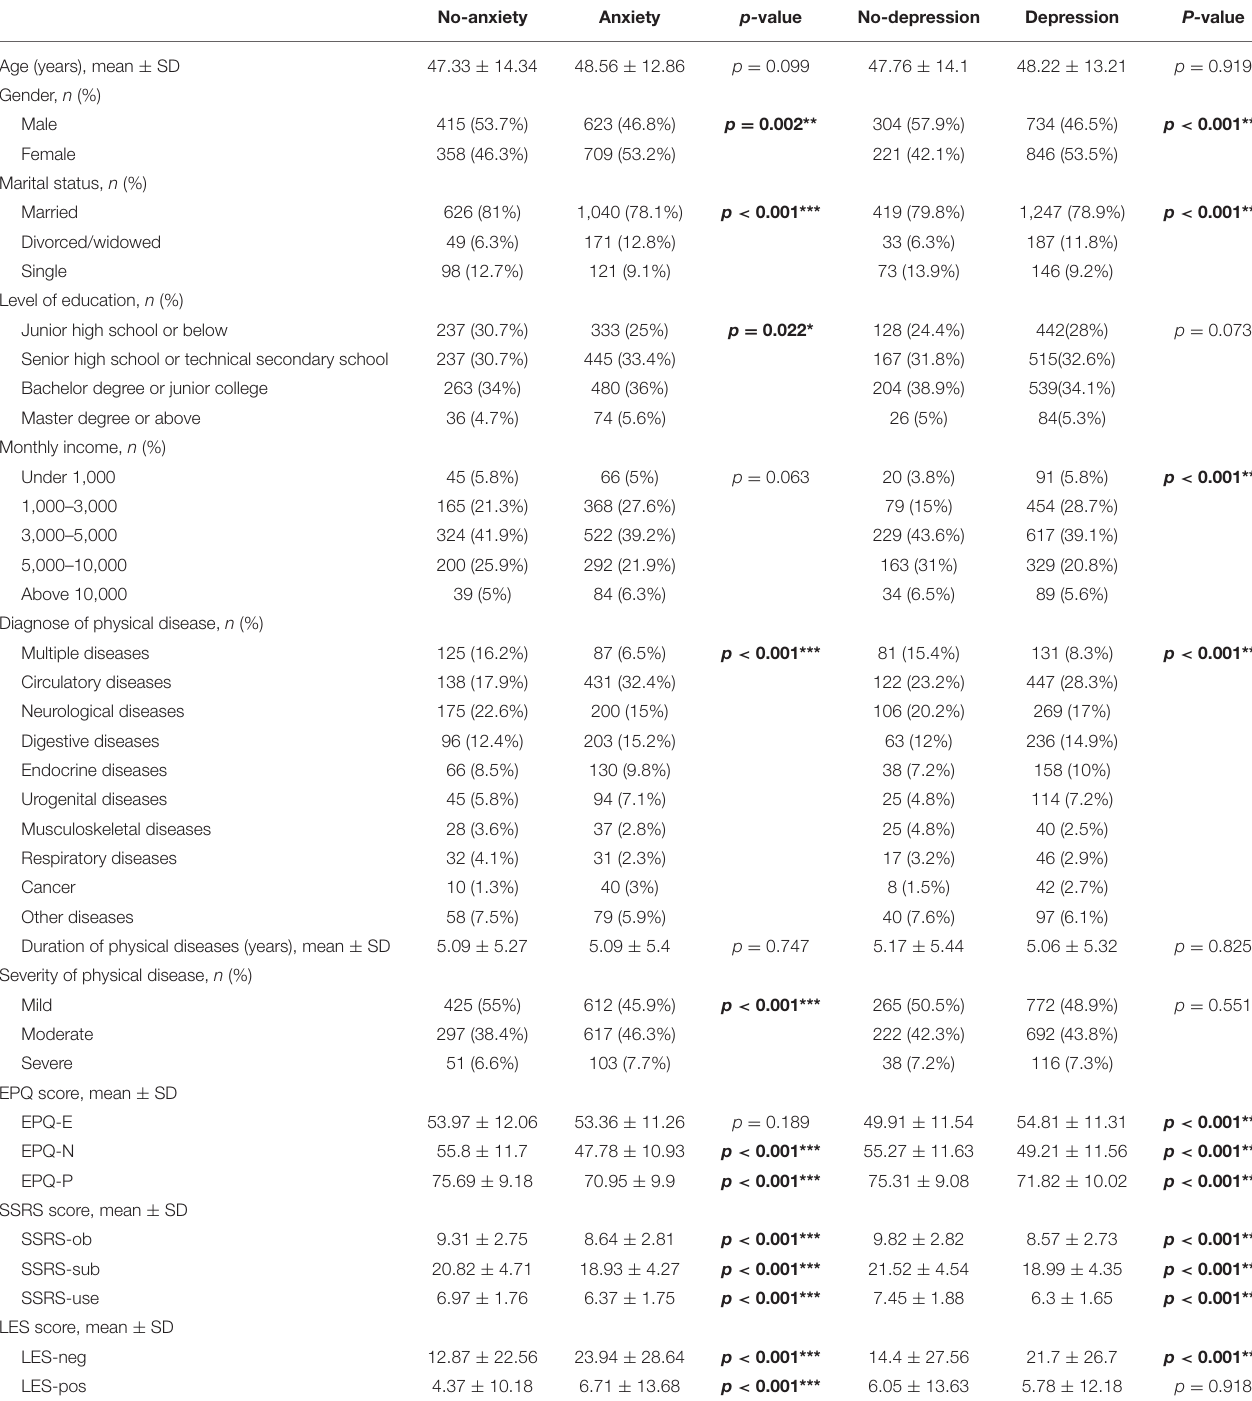
TABLE 4 | Related factors of anxiety and depression ( n = 2,105). No-anxiety Anxiety p- value No-depression Depression P-